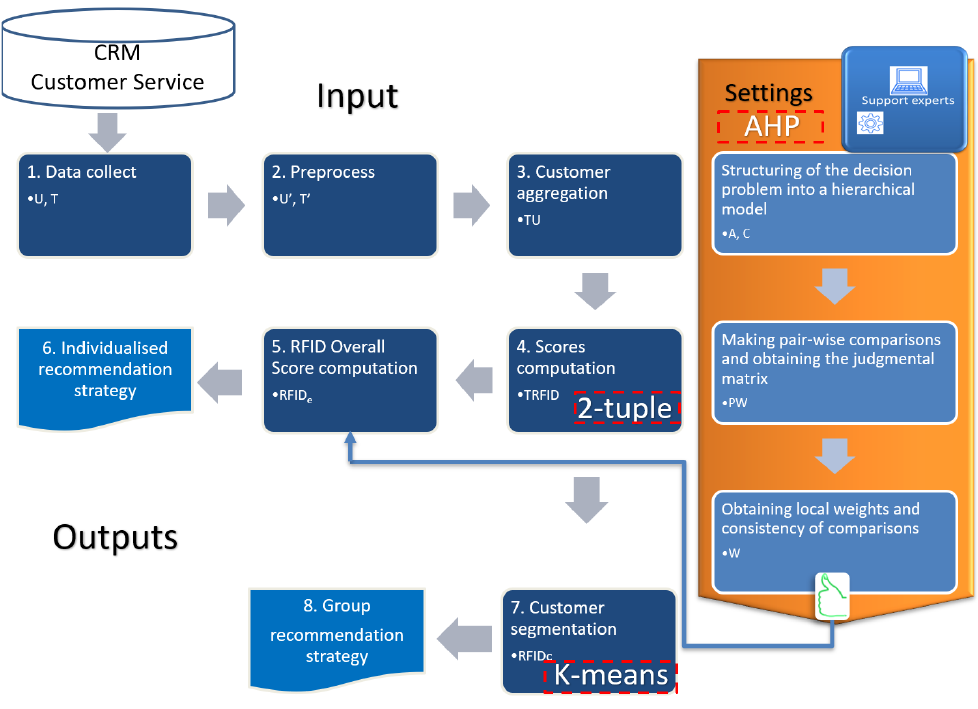
Figure 3. RFID Proposed Model.